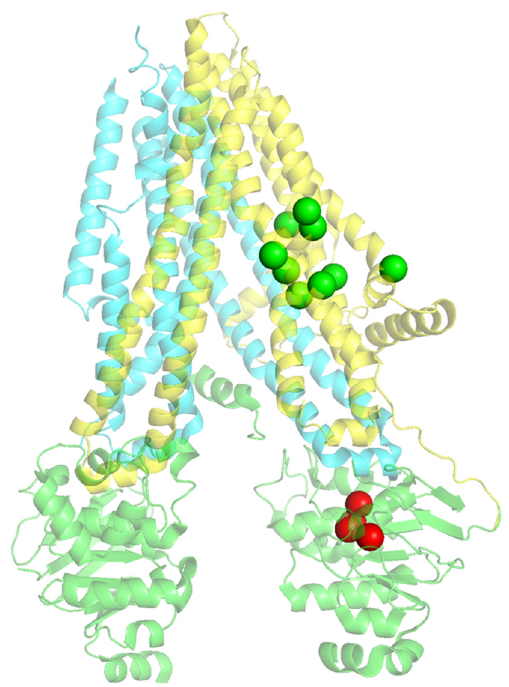
Figure 4. CFTR structure (PDB: 5UAK) with TMD1 in yellow, TMD2 in blue, and NDB1 and NBD2 in green. The green spheres represent the position of the mutations that respond to modulators, R75G, H139R, I148T, D192G, G194R, H199Y, V201M, Q359R, and W361R. The red spheres represent the position of mutations that do not respond to modulators, A559T, A559E, R560T, L558S, and L571S placed at NBD1.